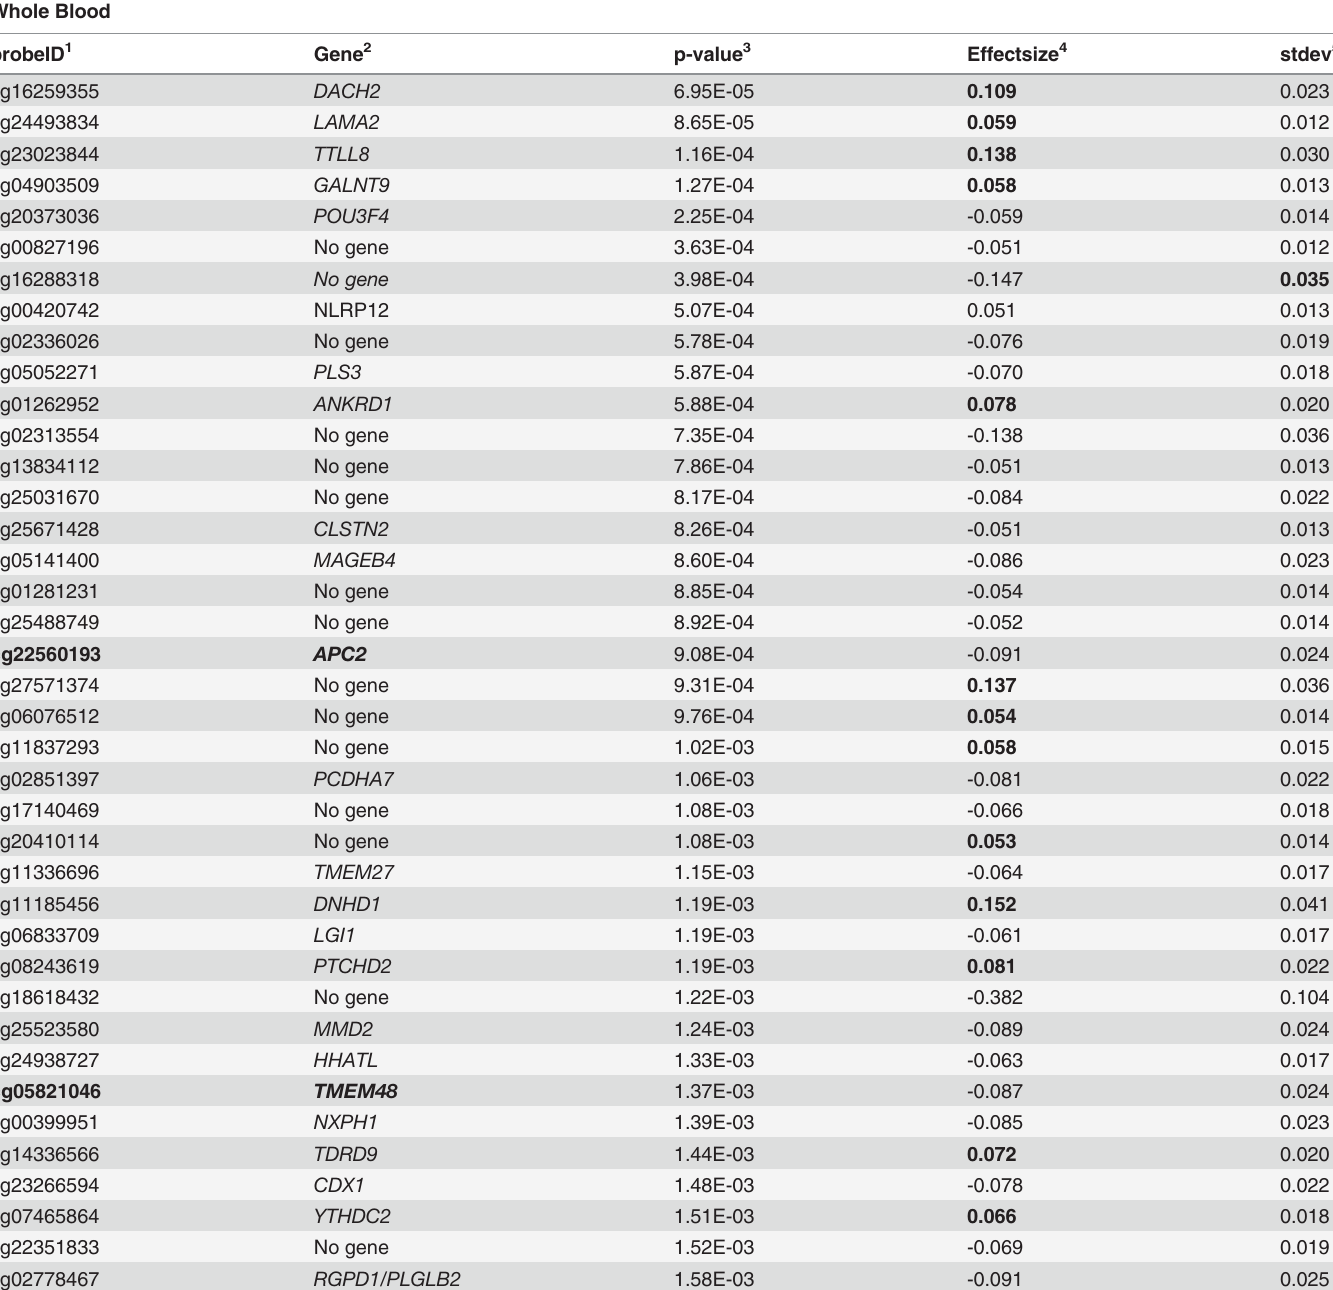
Table 4. Top 40 results sorted by p-values from linear regression analysis models of DNA methylation in whole blood samples. Whole